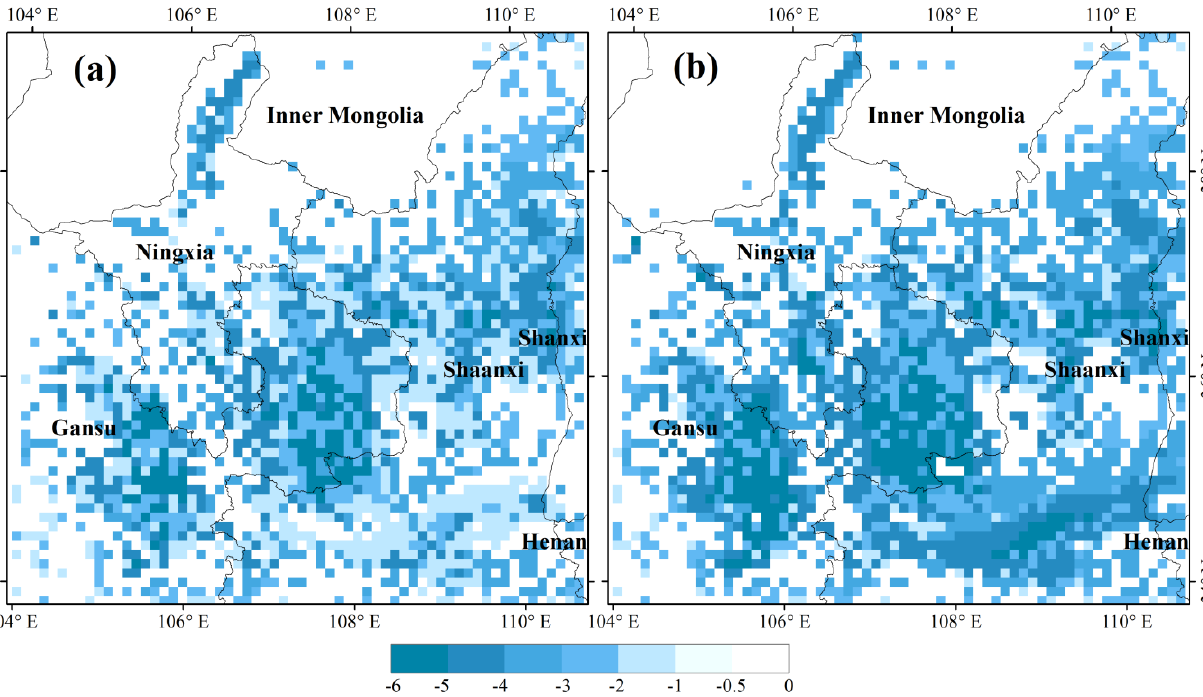
Figure 6. Annually-averaged differences in near-surface temperature (°C): ( a ) IRR-CON; and ( b ) ICE-CON. All differences shown in the map are significant at a 95% confidence